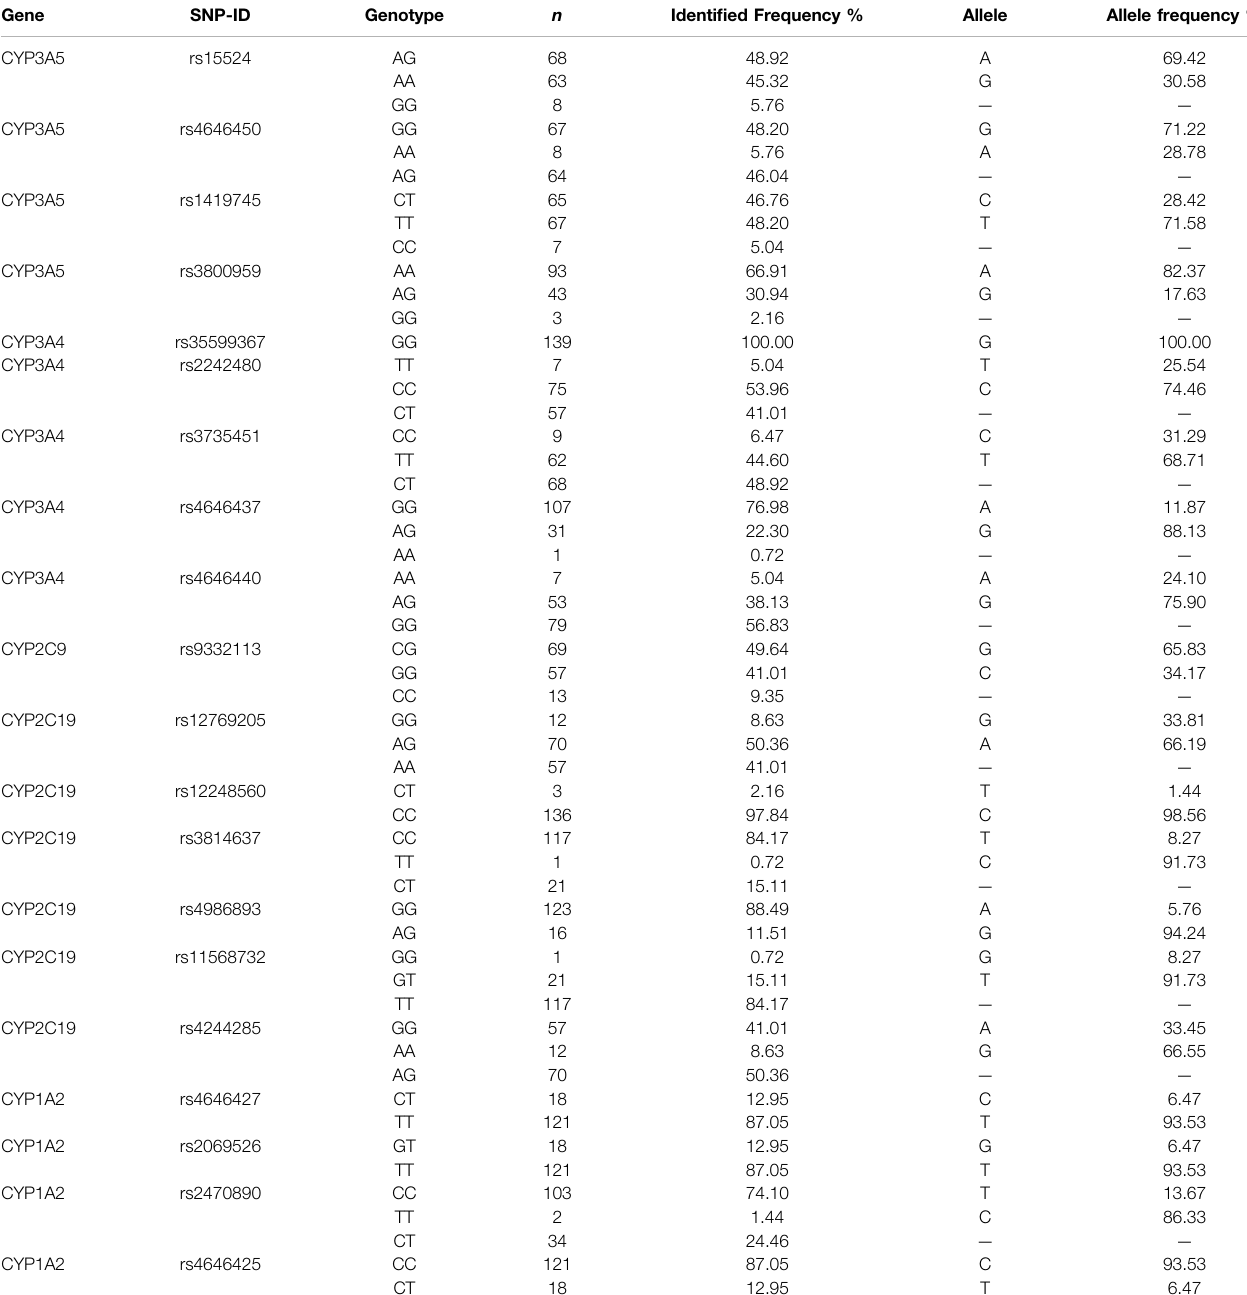
TABLE 2 | Observed genotype and allele frequency of SNPs in the present study. Gene